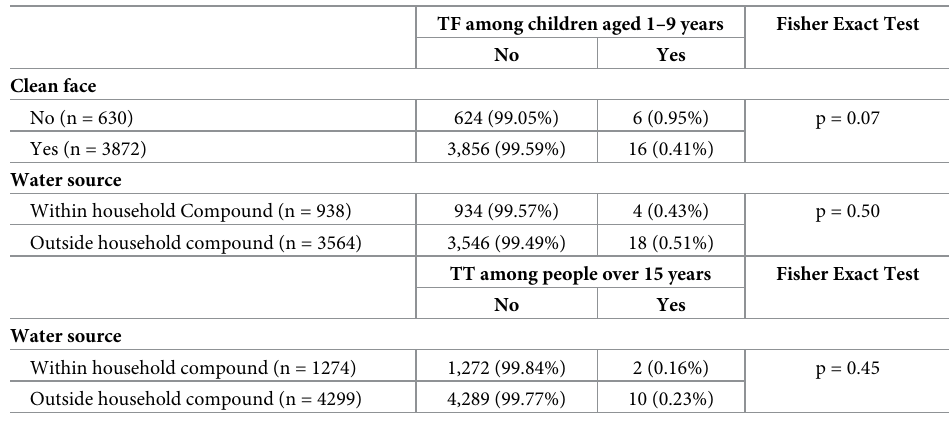
Table 5. Trachoma signs and risk